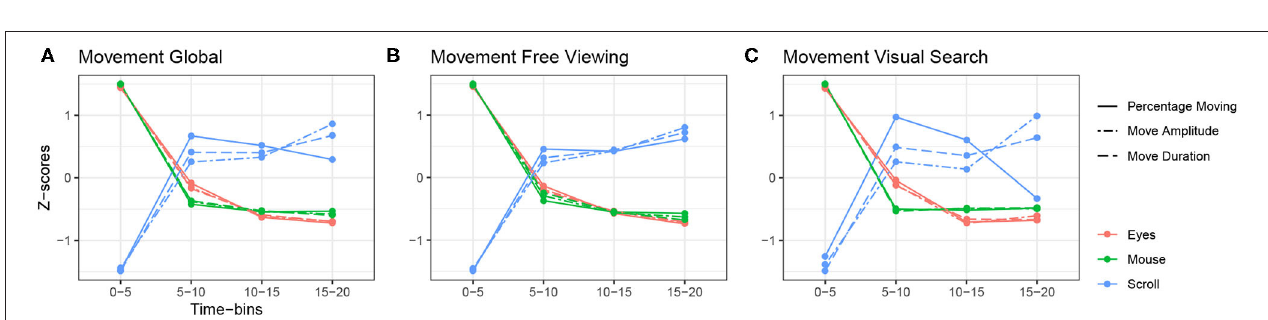
FIGURE 4 | Relationship between saccade-related variables of the eyes, mouse and scroll. (A) Global z-scored averages. (B) z-scored averages over time in the free viewing condition. (C) z-scored averages over time in the visual search